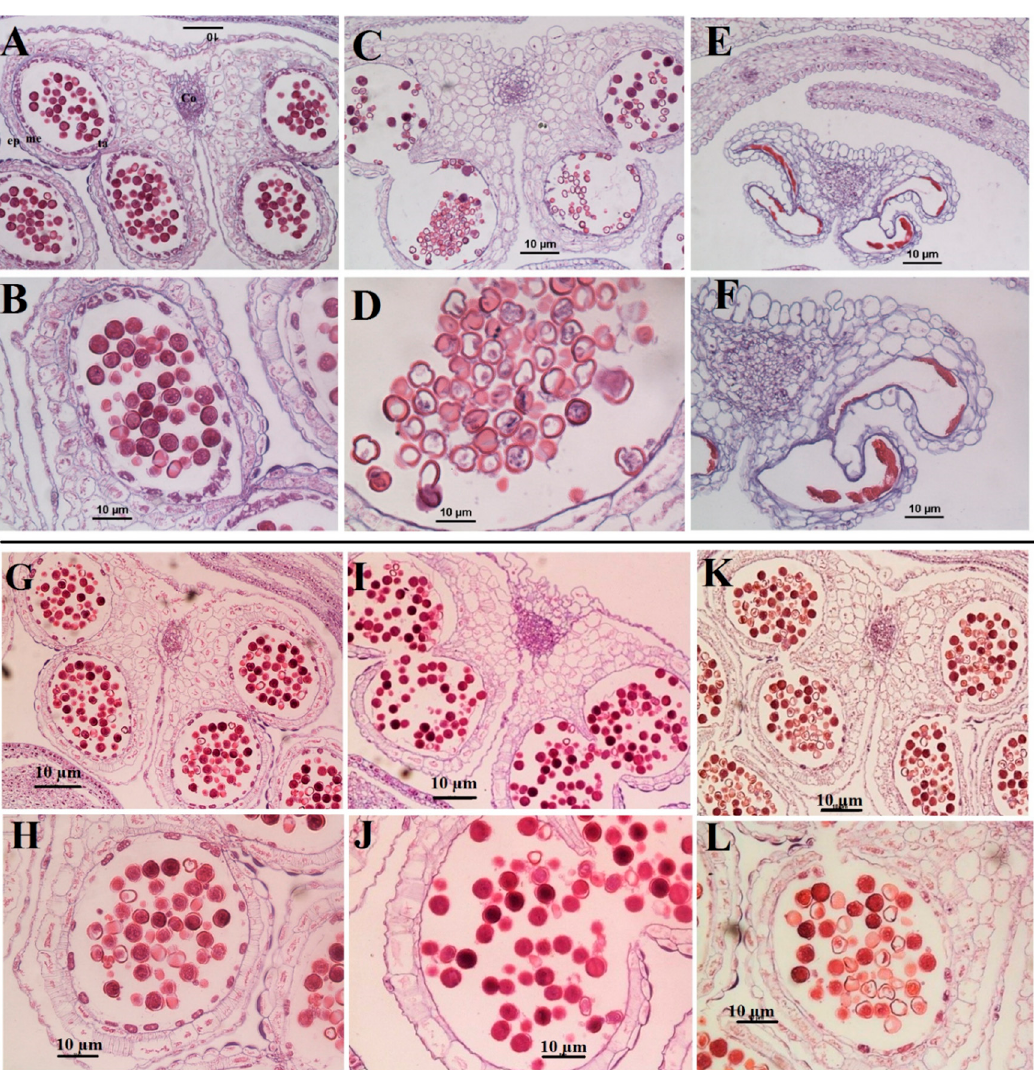
Figure 5. Transverse sections through distinct anther of B. napus . Collected from; CK ( A , B ), Cd-treated plants ( C – F ), Cd + Se ( G , H ), Cd + Mo ( I , J ), Cd + Se + Mo ( K , L ). Plants were treated with foliar spray of Se (1 mg/L) and/or Mo (0.3 mg/L) in absence or presence of Cd stress (5 mg/kg). Pollen grains are spherical in both polar and equatorial view, with dense cytoplasm and a prominent centrally located nucleus. co : connective, ep : epidermis, me : middle layer, and ta : tapetum. Bar is 10 µm.